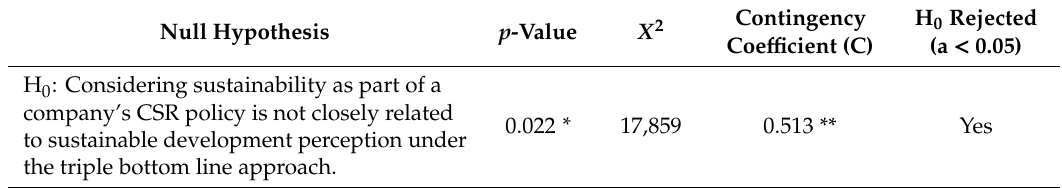
Table 2. Hypotheses 1 Testing: Chi-square test of independence and contingency coe ffi cient measure.